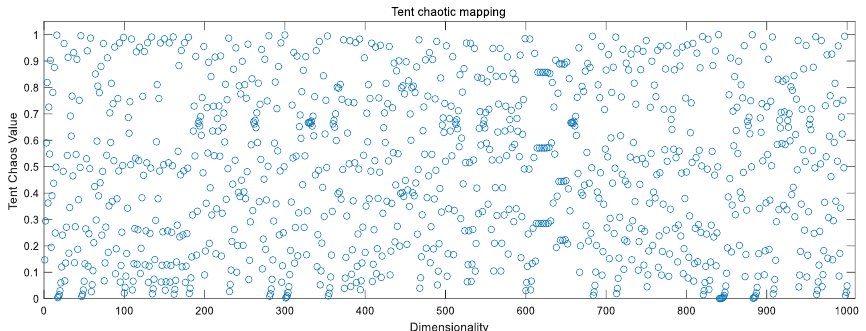
Figure 3. Logistic chaotic mapping values.